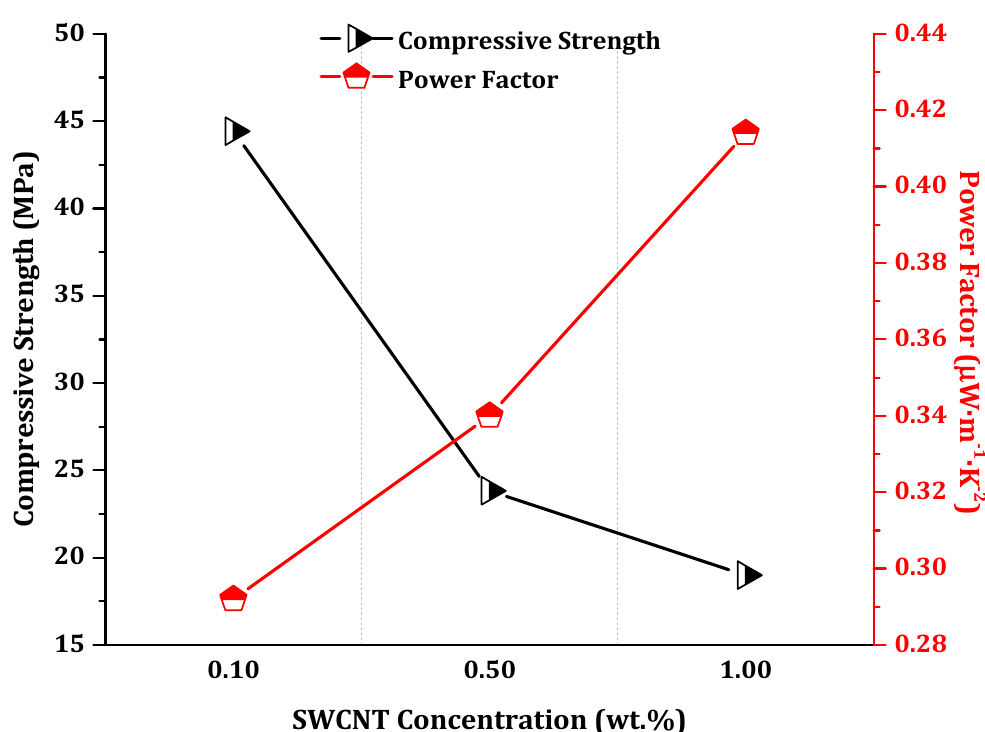
Figure 6. Inverse correlation of mechanical and thermoelectric properties of SWCNT-alkali-activated nanocomposites.